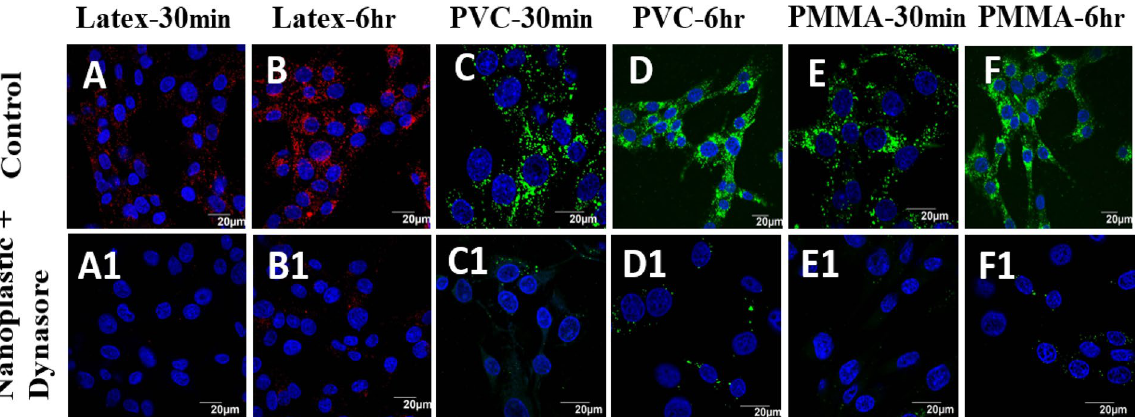
Figure 7. BHK-21 cells exposed to latex beads ( A , B ); PVC ( C , D ) and PMMA ( E , F ) NPs at a concentration of 200 µg/mL ( A – F ) and exposed to dynasore inhibitor (80 μM) and polymer NPs ( A1 – F1 ) at different time points. All images were taken under identical conditions for comparison. The images represent nucleus stained with Hoechst dye (blue), cells exposed to green fluorescent PVC or PMMA NPs and red fluorescence represent exposure to latex beads.